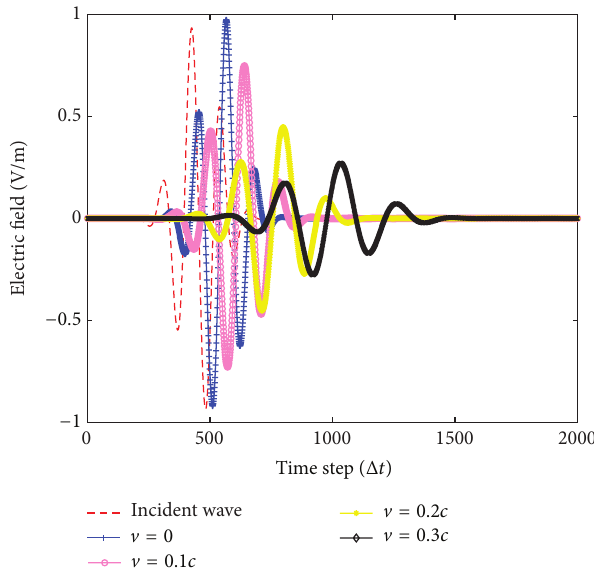
Figure 13: The time-domain scattered waveforms of the moving conducting square cylinder excited by the modulated Gaussian pulse.